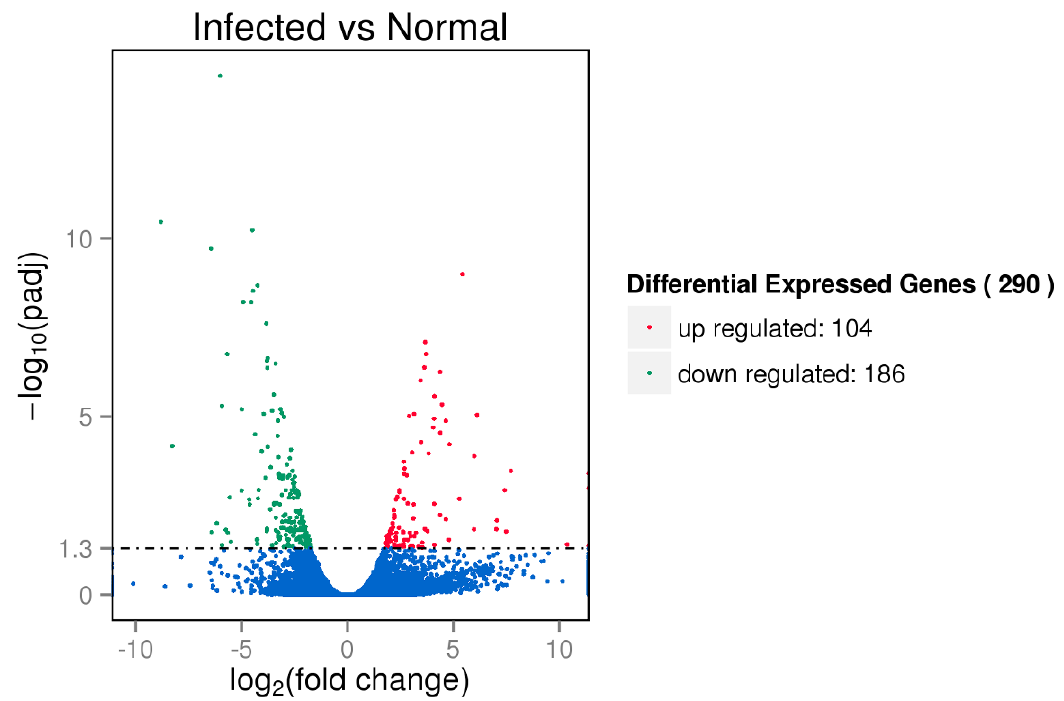
Figure 2. Volcano plot of differentially expressed genes. The red and green dots indicate the differentially up-regulated and down-regulated genes (adjusted p < 0.05), respectively.